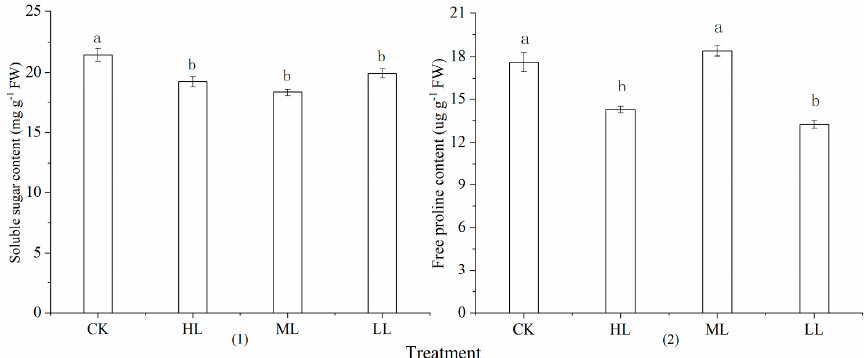
Figure 1. The soluble sugar content ( 1 ) and free proline content ( 2 ) of J. regia f. luodianense seedlings